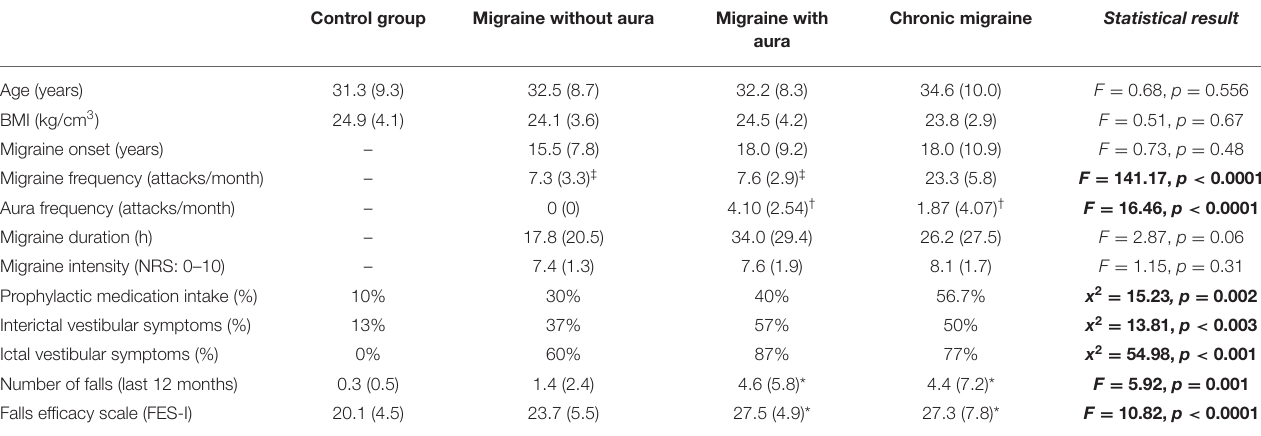
TABLE 1 | Mean (SD) and percentages (%) of the sample demographic